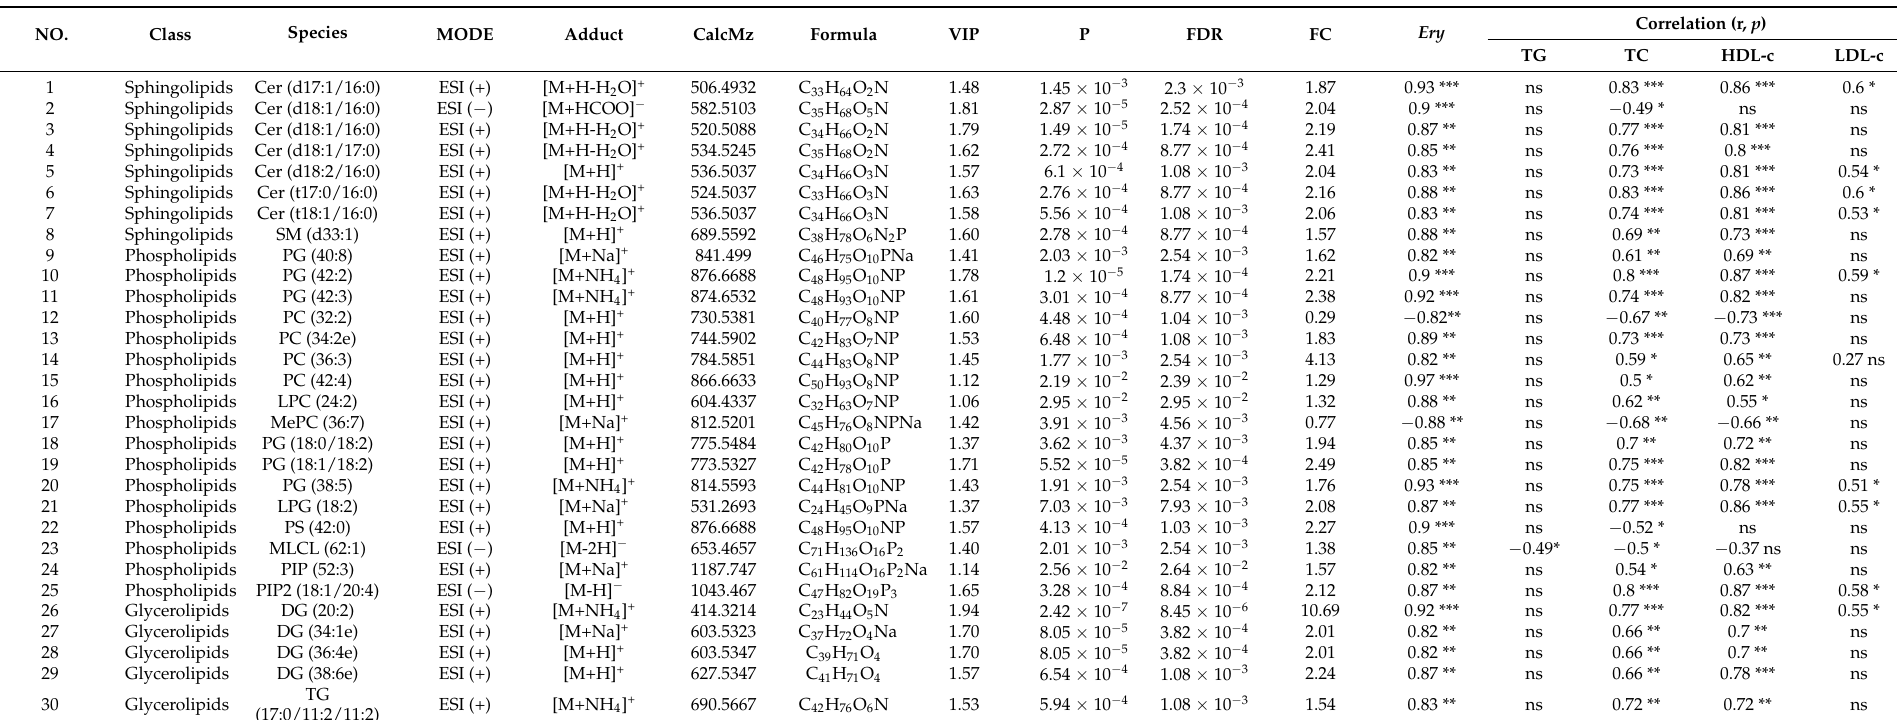
Table 1. Correlation analyses showing the associations of significantly differential lipid species with intestinal Erysipelotrichaceae family and hepatic total cholesterol and HDL-cholesterol ( p < 0.05,